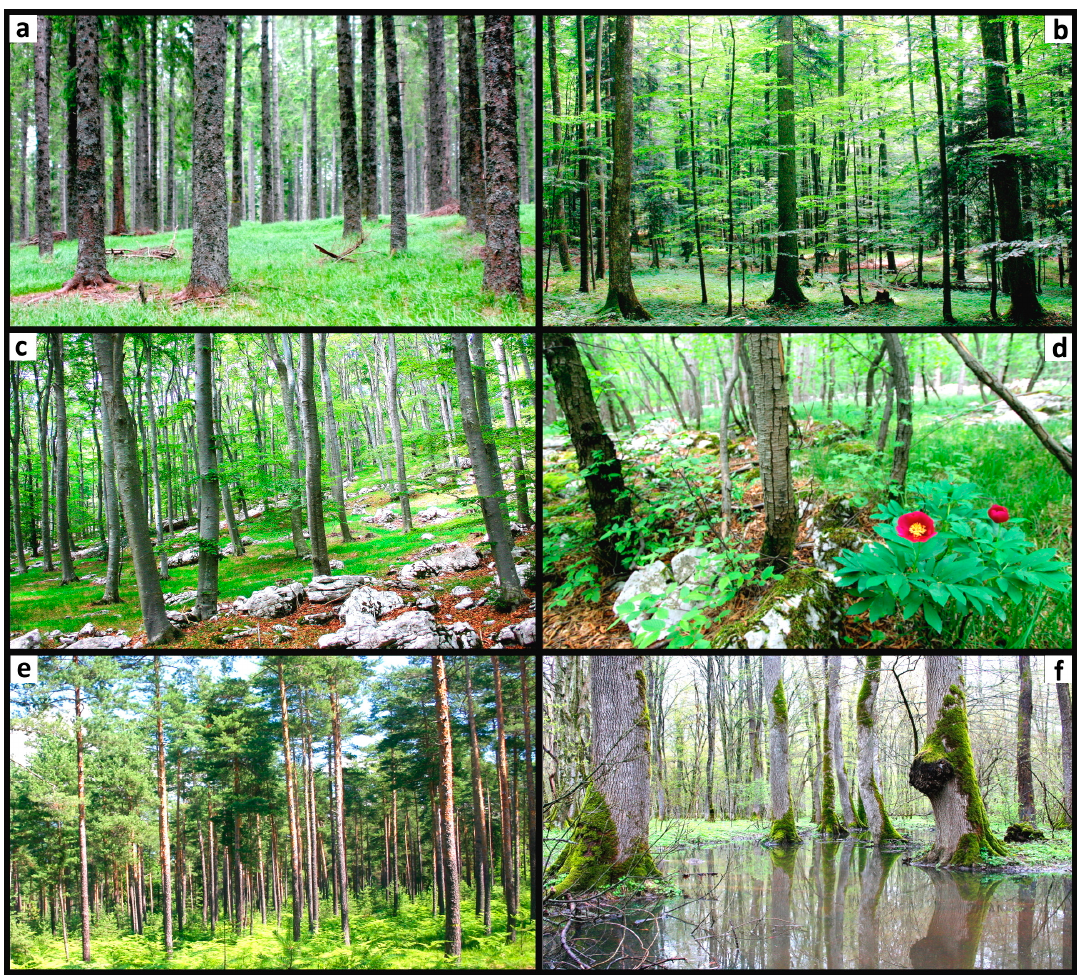
Figure 1. Distinct forest vegetation types from the Intensive Monitoring (IM) sites in Slovenia: ( a ) Mountain spruce forest (6-KL), ( b ) Dinaric fir-beech forest (9-GO), ( c ) Thermophilous beech forest (2-FO), ( d ) Secondary Austrian pine forest with thermophilous deciduous trees (3-GB), ( e ) Scots pine forest (4-BR) and ( f ) Lowland oak-hornbeam forest (10-KG). For study site abbreviations, see Table 1. We sampled forest vegetation according to standardized sampling protocols [56]. In all Lplots and Splots, all vascular plant species in the tree, shrub and herb layer were recorded. The percentage cover of each species was visually estimated using a modification of Barkman’s method ([57], for Lplots) and Londo’s method ([58], for Splots). For the analyses, we used the percentage class mid-